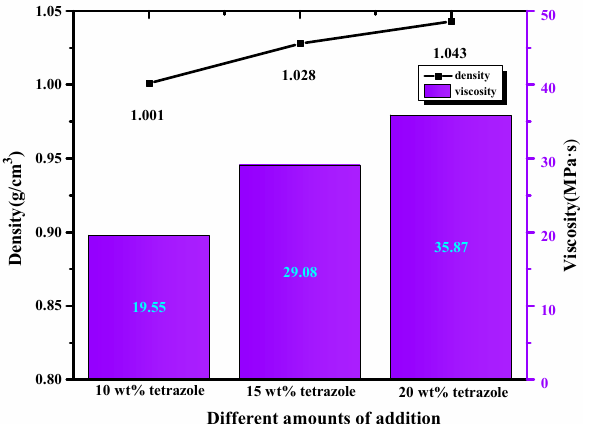
Figure 7. Density and viscosity of the different mass ratios additions in the 1-methylimidazole borane complex.